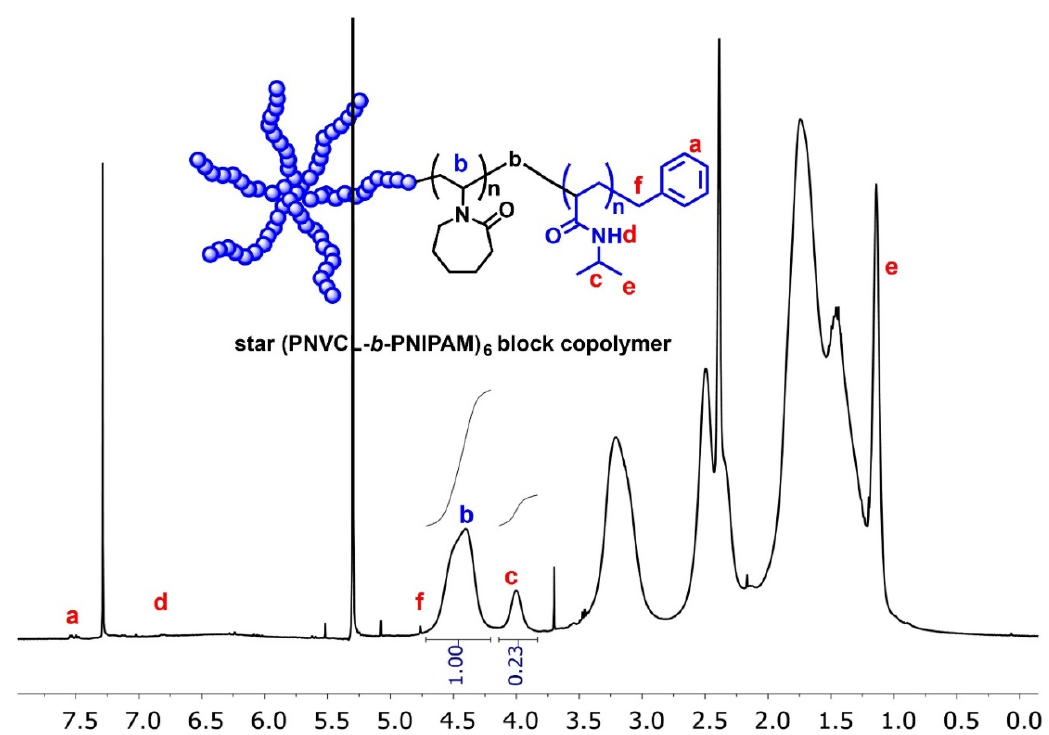
Figure 8. 1 H NMR spectrum (400 MHz) in CDCl 3 of the (PNVCL- b -PNIPAM 19% ) 6 star block copolymer ( M n GPC = 47,320 g/mol, Ð = 1.27).